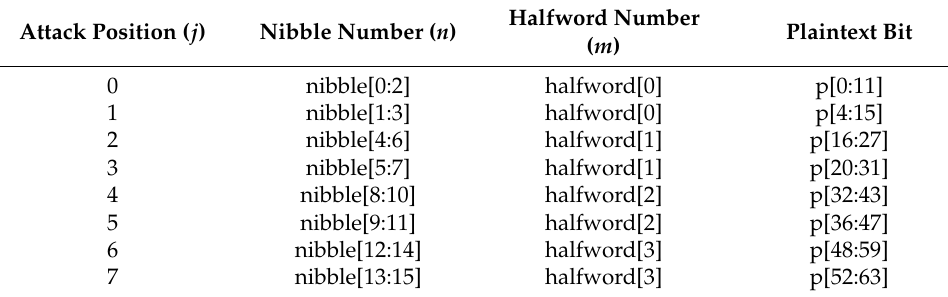
Figure 2. Schematic diagram of PRINCE leakage model. Table 2. Explanation table of attack